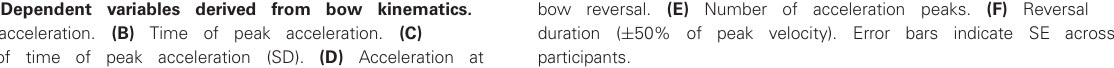
bow reversal. (E) Number of acceleration peaks. (F) Reversal duration ( ± 50% of peak velocity). Error bars indicate SE across